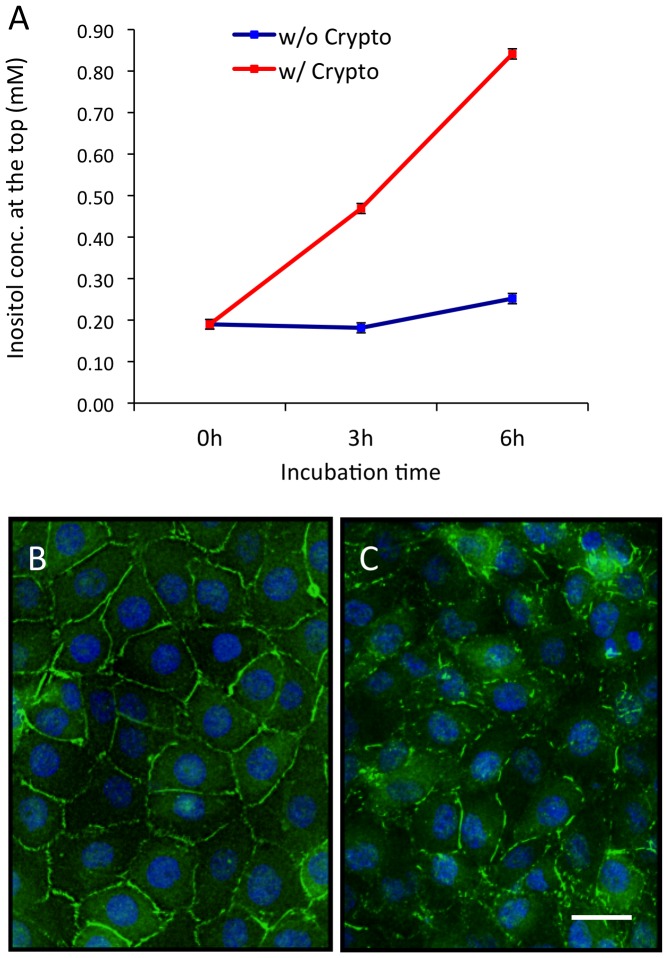
Determination of myo-inositol concentration in the top compartment.(A) The in vitro human BBB model was prepared with 1 mM inositol in the bottom compartment and incubated with or without 105
Cryptococcus cells in the top compartment. After 3 and 6 hr incubations, the medium in the top compartment was collected and inositol concentration was determined. (B and C) Confluent HBMEC monolayers grown on the collagen-coated glass coverslips were incubated with medium only (B) or with the wild type H99 (C) for 1 hr. The cells were incubated with ZO-1 antibody, followed by Alexa488-conjugated secondary antibody. The coverslips were mounted on slides with Vectashield mounting solution containing DAPI and observed under a fluorescence microscope. ZO-1 (green) and nuclei (blue) are shown. Bar indicates 50 µm.